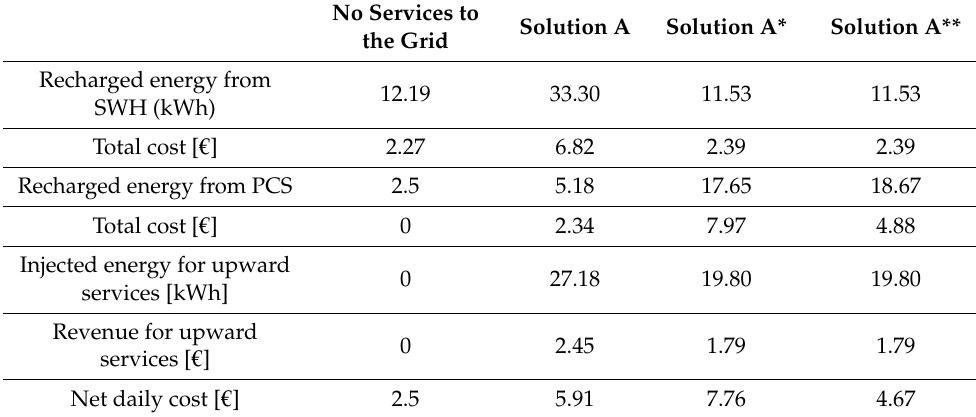
Table 18. Results of different solutions for mobility pattern